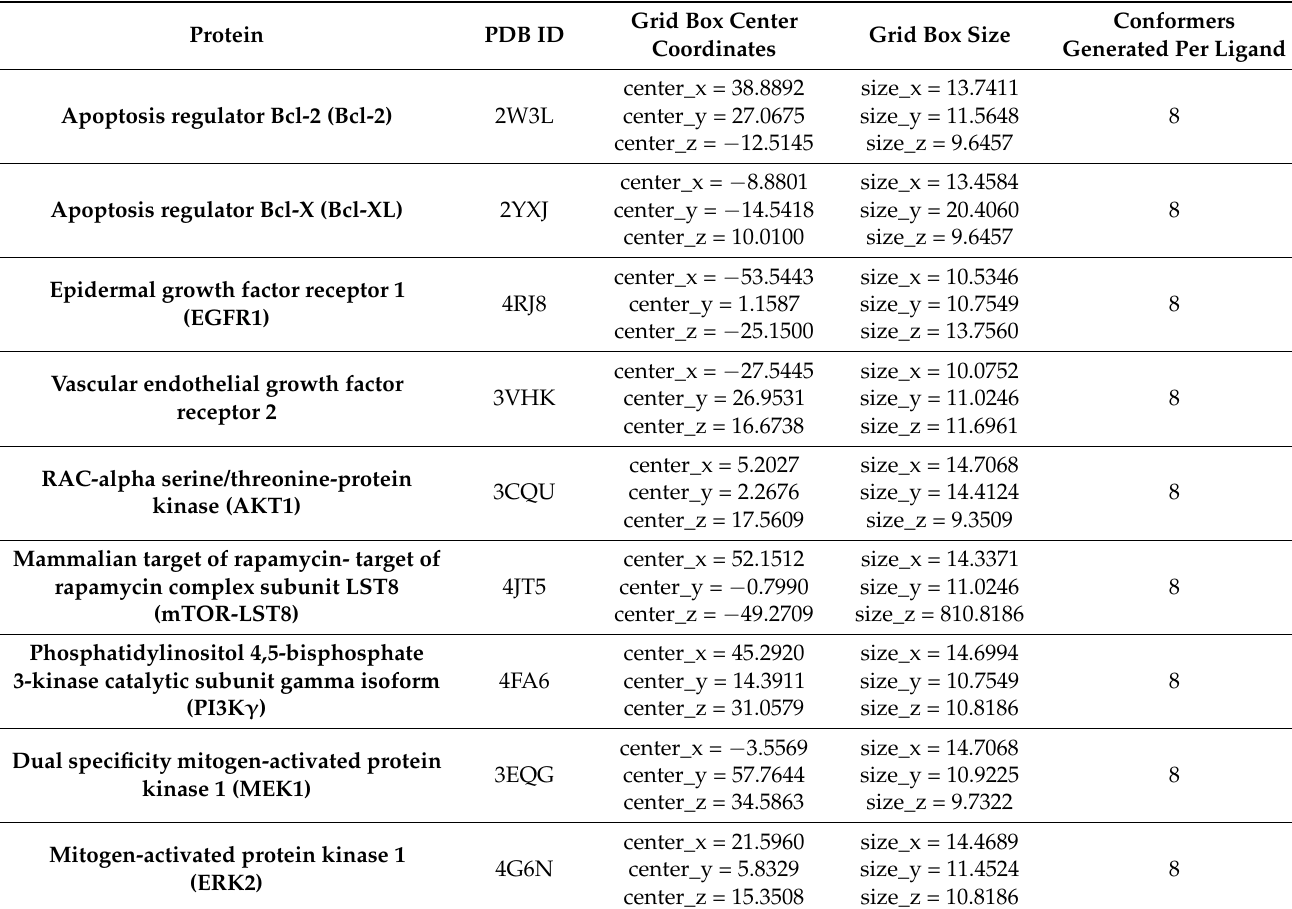
Table 1. Molecular docking parameters used for each protein